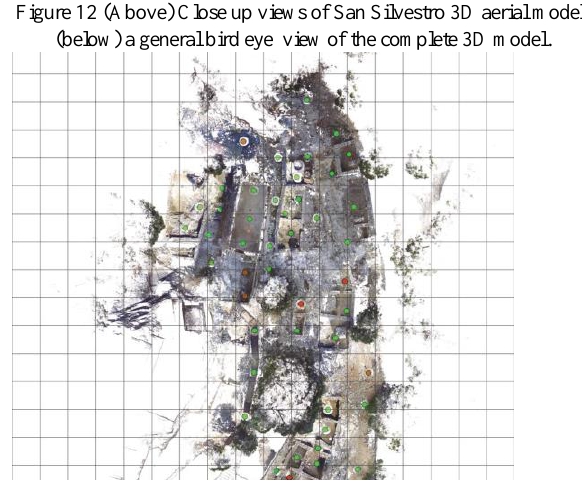
Figure 12 (Above) Close up views of San Silvestro 3D aerial model, (below) a general bird eye view of the complete 3D model.